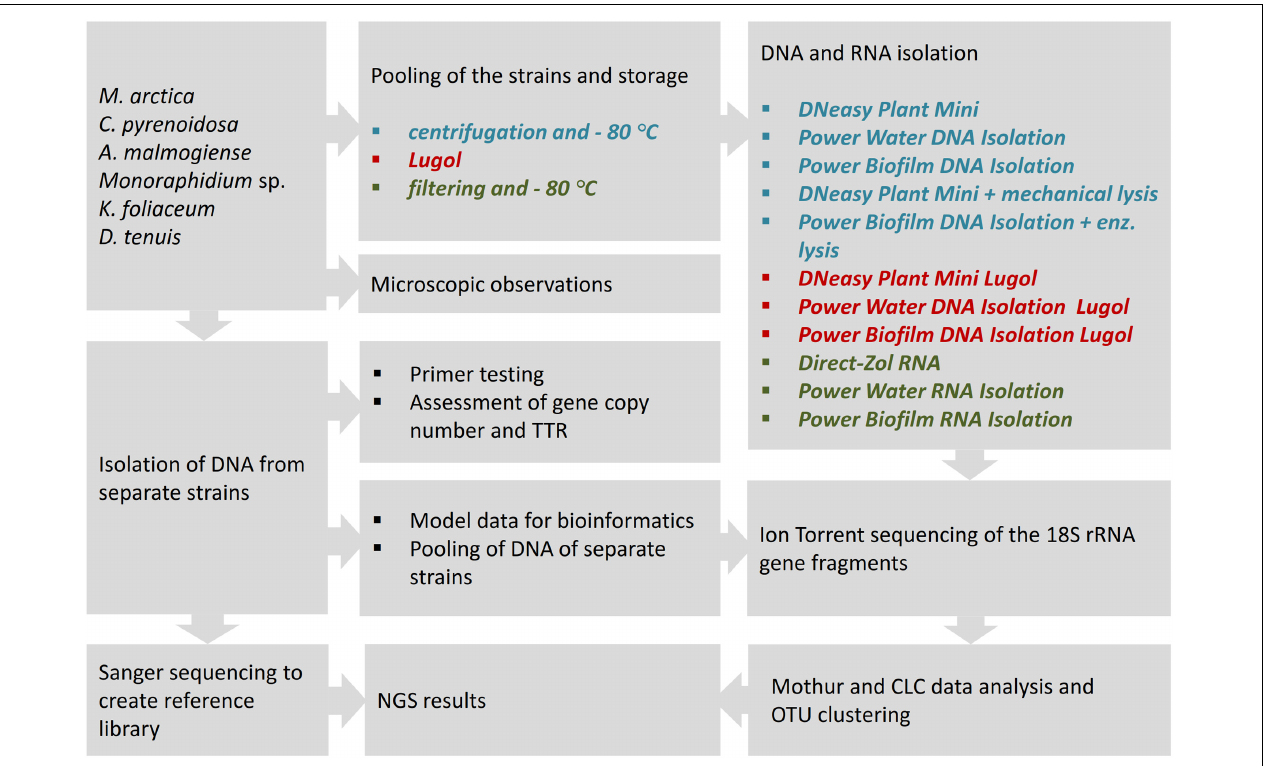
FIGURE 1 | The study strategy for the NGS analysis of a mock community, comprising of six phytoplankton strains, to compare cell-preserving and nucleic acids extraction methods. For nucleic acid isolation, three DNA extraction kits with their enzymatic or mechanical cell lysing modifications, and three RNA extraction methods were applied to study cell pools, preserved at –80 ◦ C or in acidic Lugol’s solution. TTR refers to theoretical template relationship, OTU refers to operational taxonomic unit. Full strain names are presented in Section “Materials and